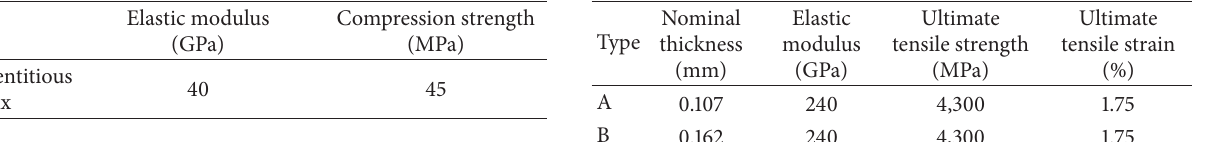
Table 3: Mechanical properties of cementitious matrix. Table 4: Mechanical properties of FRP fabric.